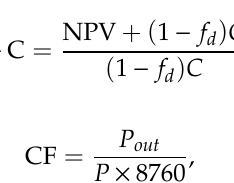
Figure 4. NASA mean monthly wind speed for all selected regions in Libya.